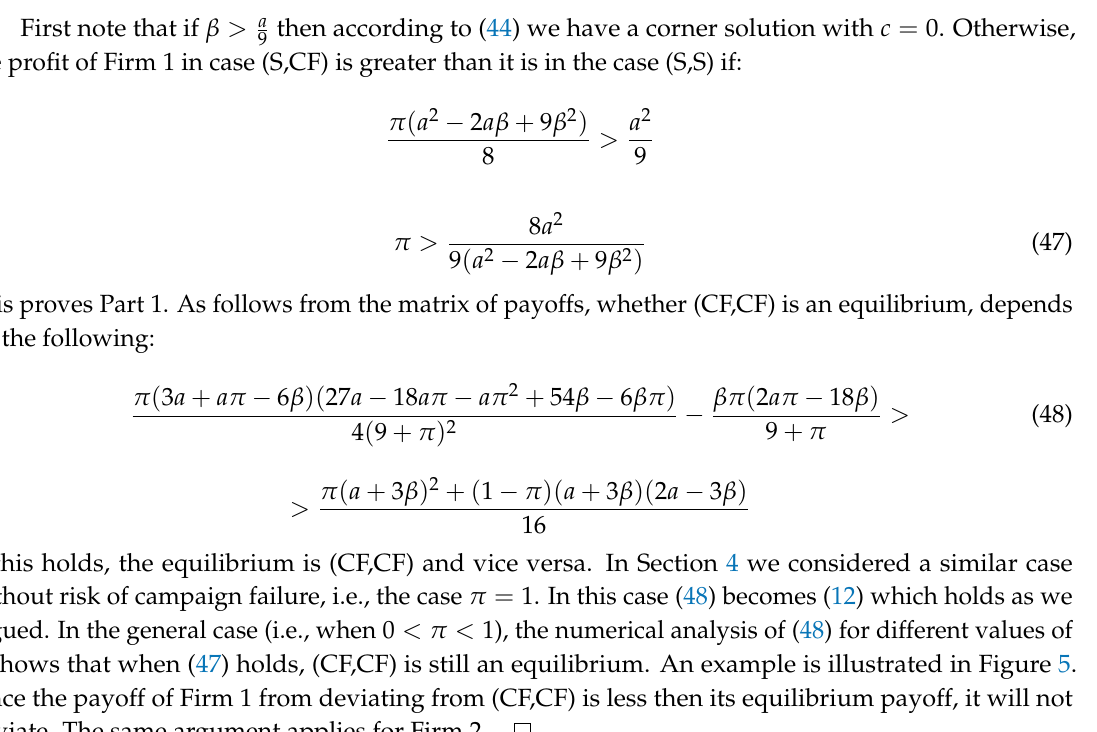
Figure 4. Matrix of payoffs under risk of campaign